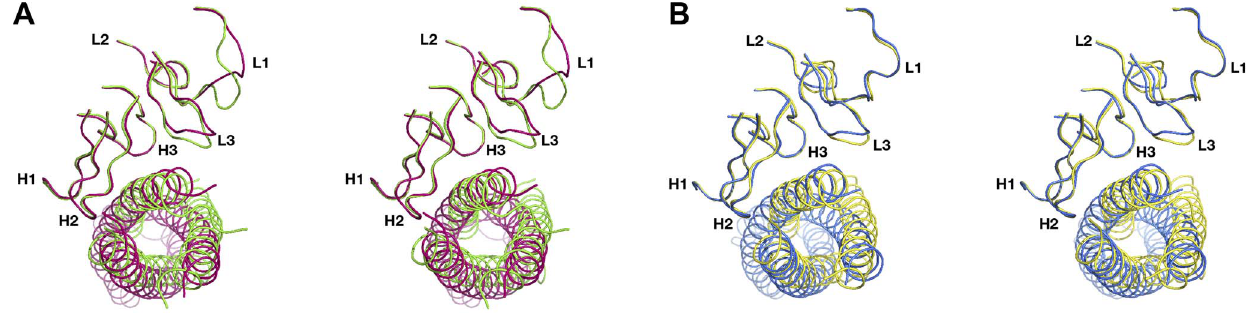
Figure 13. Pairwise comparison of all CDRs in a single antibody. The complexes of Fabs 8066 (A) and 8062 (B) with 3-H and 5-Helix were superimposed using the C a traces of the b -sheet frameworks of the variable domains. N-HR helices and CDR loops of the (Fab 8066) 3 /3-H complex are shown in red, of the 8066/5-Helix complex are in green, of the (Fab 8062) 3 /3-H complex are in blue, and of the 8062/5-Helix complex are in yellow.